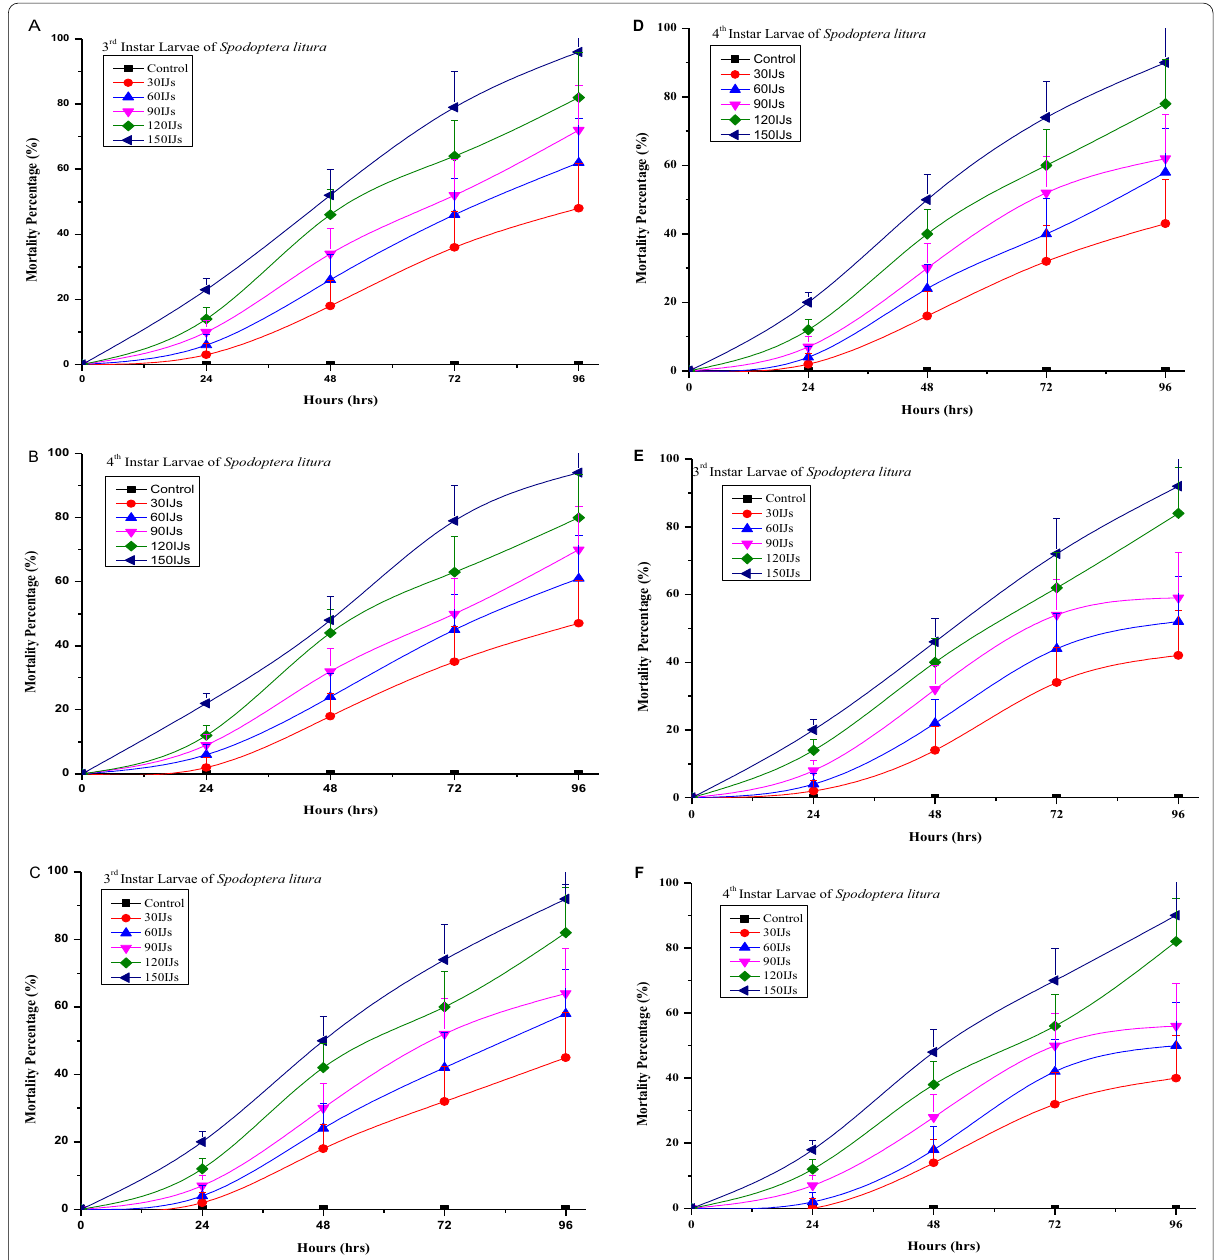
Fig. 2 Percent mortality caused by Heterorhabditis bacteriophora strains in 3rd and 4th larval instars of Spodoptera litura ( A and B ) Mortality caused by Heterorhabditis bacteriophora EUPT-SD; ( C and D ) Mortality caused by Heterorhabditis bacteriophora EUPT-R; ( E and F ) Mortality caused by Heterorhabditis bacteriophora EUPT-KN; ( G and H ) Mortality caused by Heterorhabditis bacteriophora EUPT-K; and ( I and J ) Mortality caused by Heterorhabditis bacteriophora